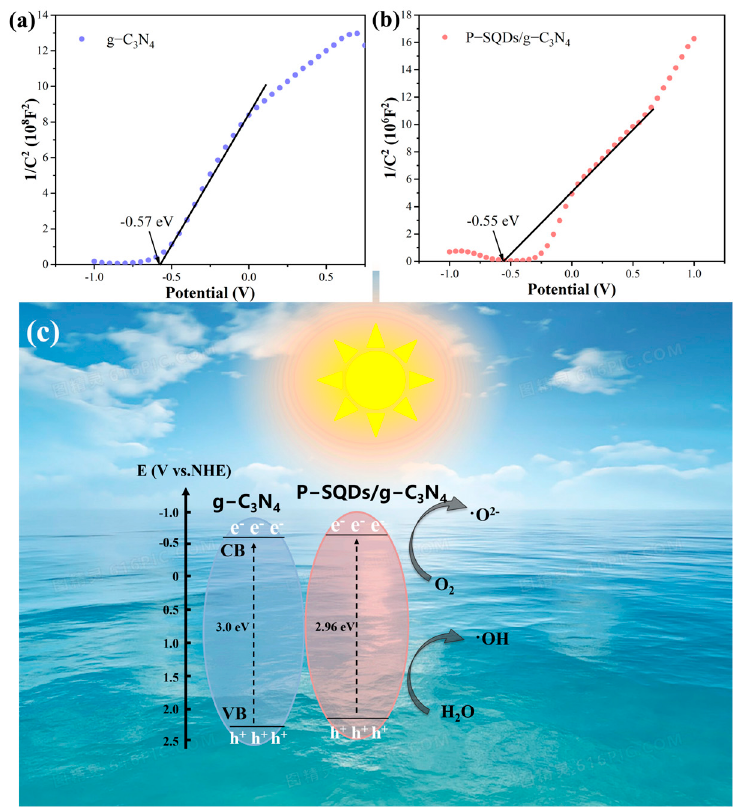
Figure 8. Mott-Schottky curves of ( a ) g-C 3 N 4 and ( b ) P-SQDs/g-C 3 N 4 . ( c ) Schematic diagram of photocatalytic mechanism of the P-SQDs/g-C 3 N 4 under visible light irradiation.